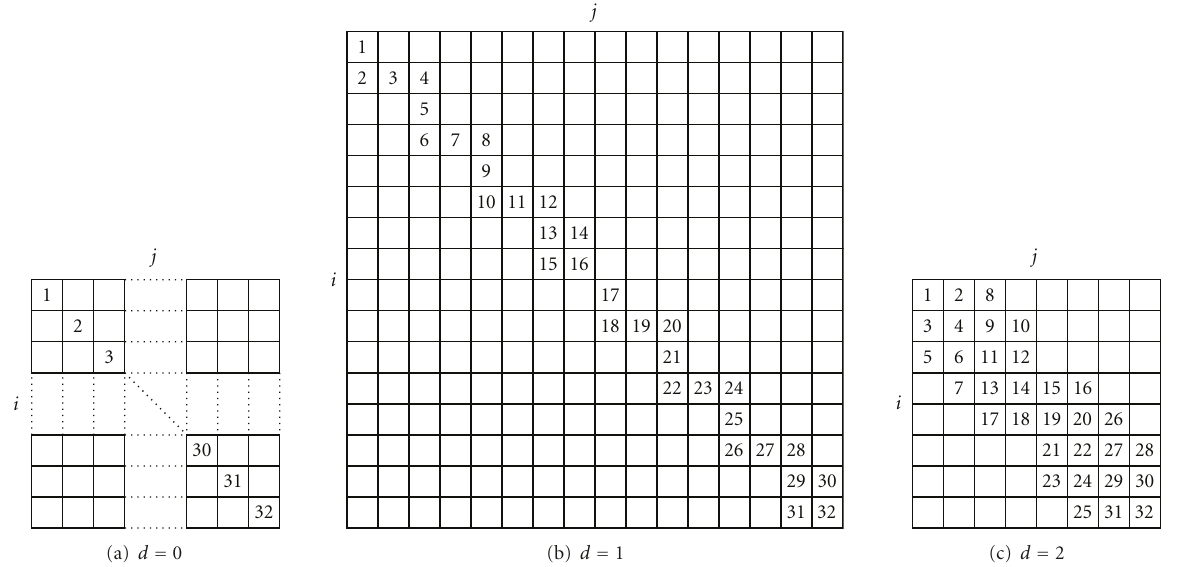
Figure 3: MDSQ index assignment for a central codebook of dimension Q = 32, with (a) 1 diagonal ( d = 0), (b) 3 diagonals ( d = 1), and (c) 5 diagonals ( d = 2), where 2 d + 1 is the number of diagonals covered by the index assignment.